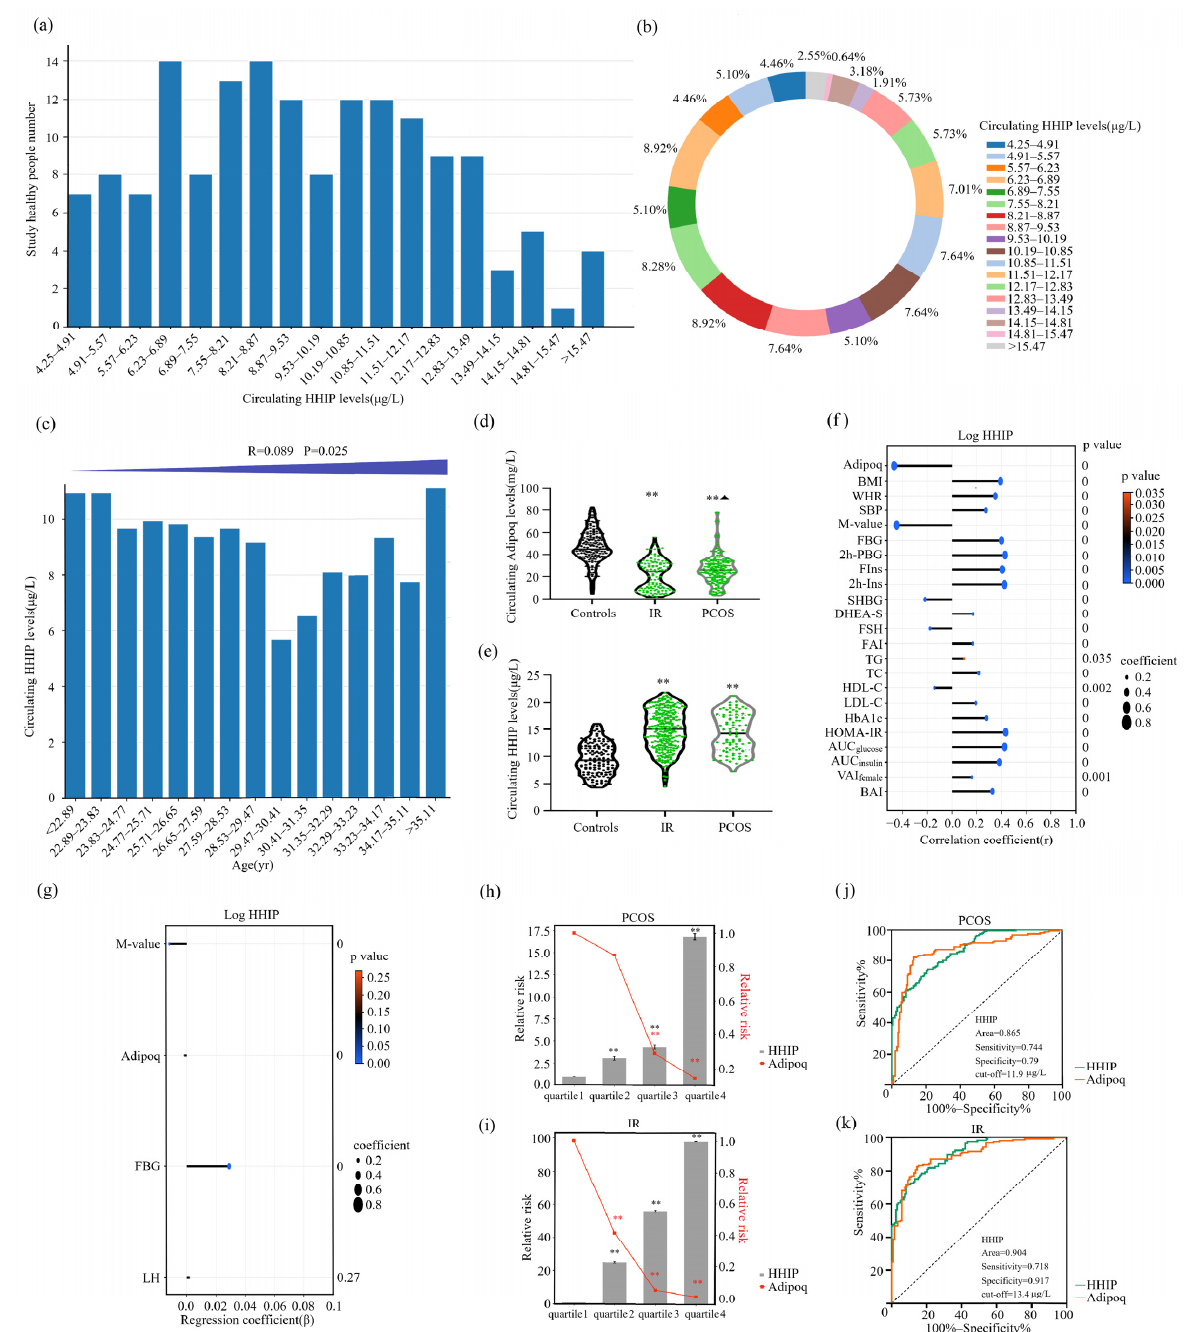
Figure 2. Serum HHIP level in the study population and its relationship with other parameters. ( a ) Distribution of serum HHIP in healthy women. ( b ) Percentage of serum HHIP concentration distribution in normal women. ( c ) Distribution of serum HHIP concentration in normal women of different ages. ( d , e ) Serum HHIP and adipoq concentration in IR, PCOS and healthy women. ( f ) Linear correlation analysis for serum HHIP and other variables. ( g ) Multiple regression analyses for serum HHIP and other variables. ( h ) Prevalence of elevated PCOS in different quartiles of HHIP and adipoq. ( i ) Prevalence of elevated IR in different quartiles of HHIP and adipoq. ( j , k ) ROC curve analyses for the prediction of PCOS ( j ) and IR ( k ) according to serum HHIP levels. Data are expressed as mean ± SD or median (Interquartile Range). ** p < 0.01 vs. controls or. quartile 1; compared with IR